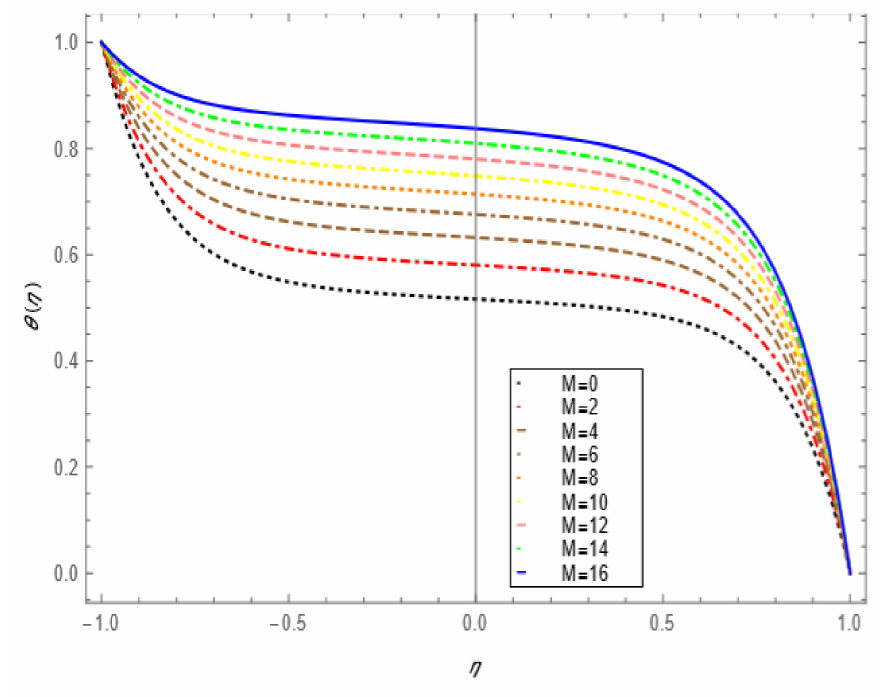
Figure 5. Temperature profile effect for magnetic parameter for = 1, Re = 1, ϕ 1 = ϕ 2 = 0.01, Ec = 0.00068, Pr = 6.2.